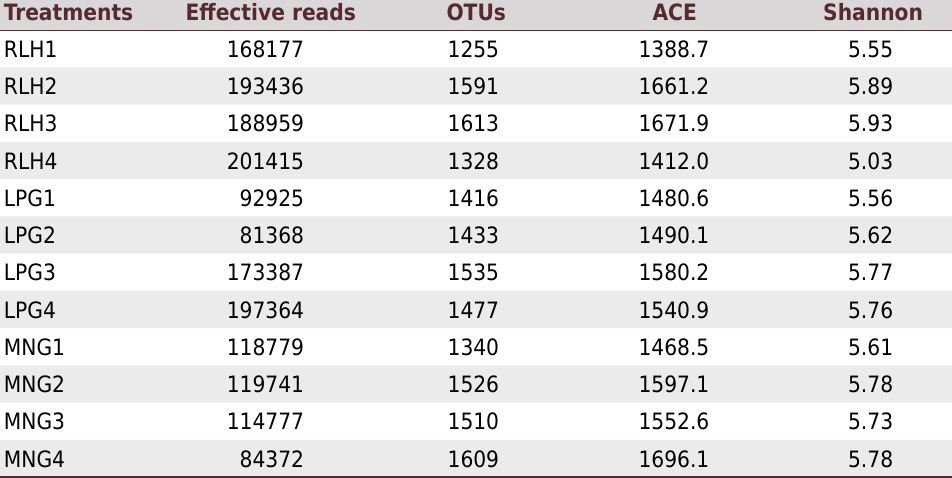
Table 2. Bacterial diversity (Shannon) and richness, number of operational taxonomic units (OTUs), and abundance-based coverage estimator (ACE) of soil samples subjected to the following treatments: RLH, LPG, and MNG Treatments